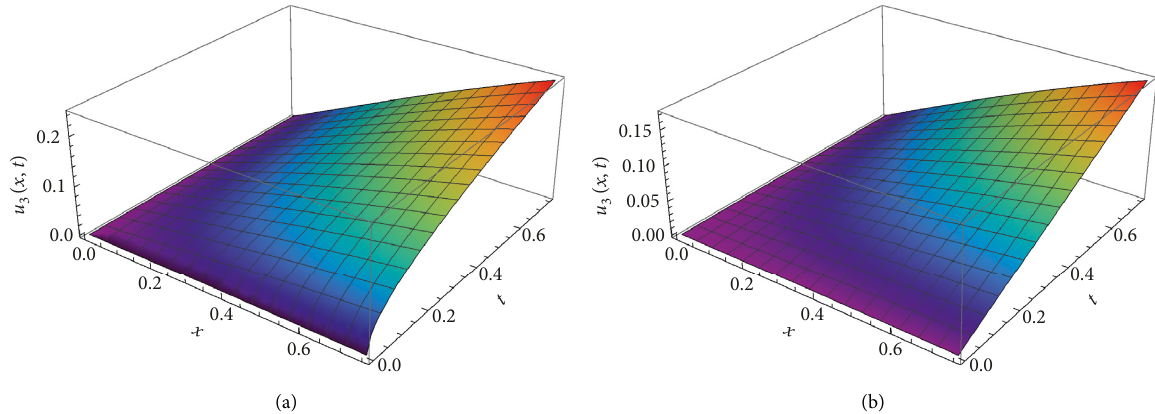
Figure 7: The graphs of the third-order iterative solution u ( x,t ) for (30) through various values of x,t at α � 0 . 5 , 1, respectively. (a) The 3 ( x,t ) for (30) through various values of x, t at α � 0 . 5. (b) The graph of the third-order iterative graph of third-order iterative solution u 3 ( x,t ) for (30) through various values of x,t at α � 1. solution u 3